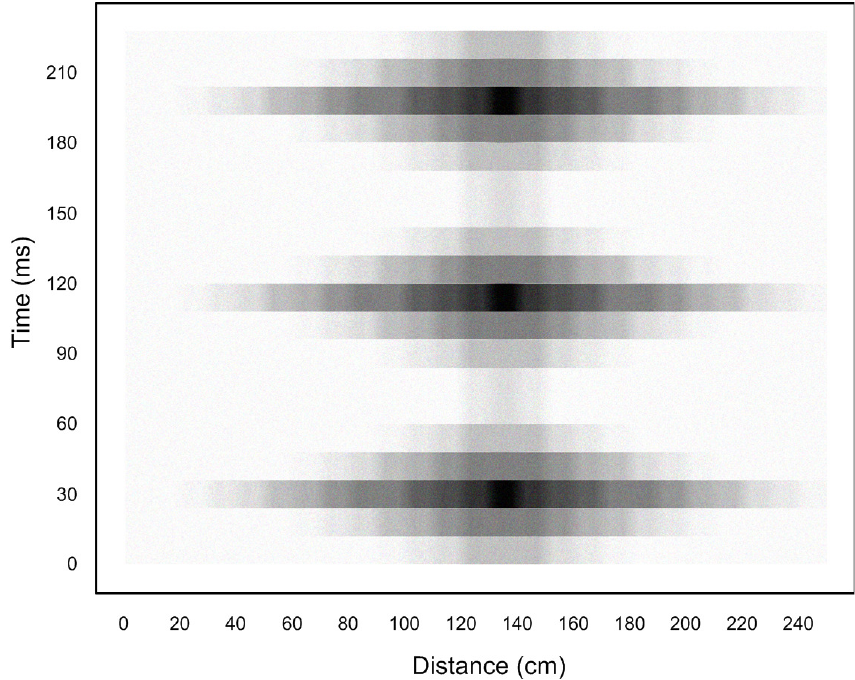
Figure 9. Time–distance data plot. Frequency = 5.1 Hz. (Shading represents intensity of reflected light).